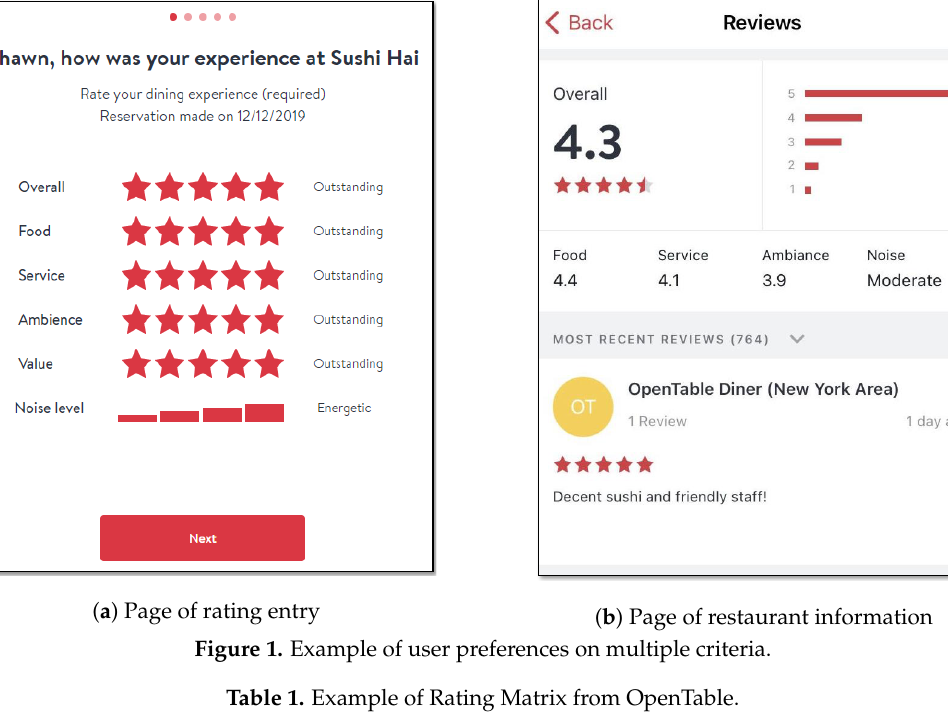
Table 1. Example of Rating Matrix from OpenTable